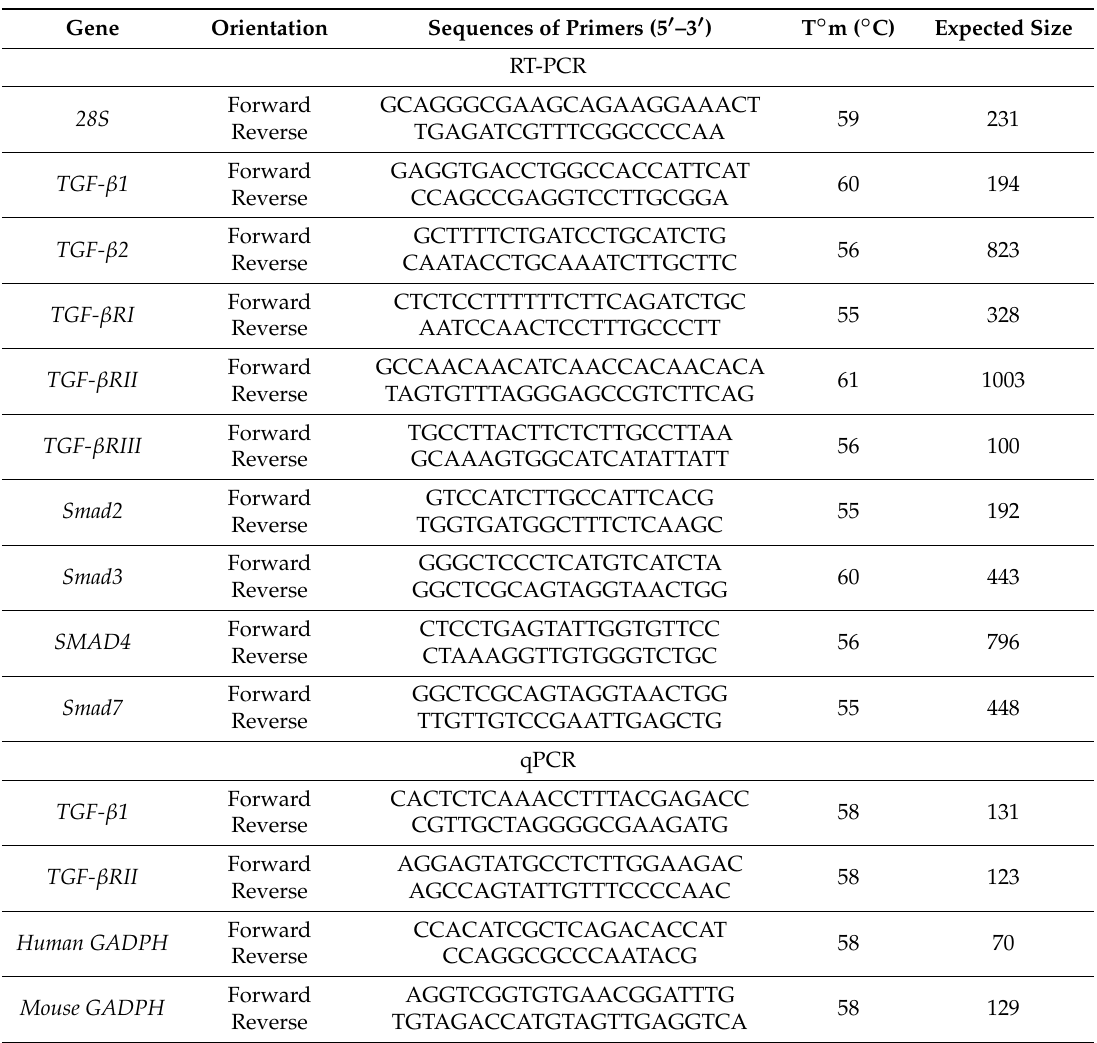
Table 1. Primers used for RT-PCR and qPCR